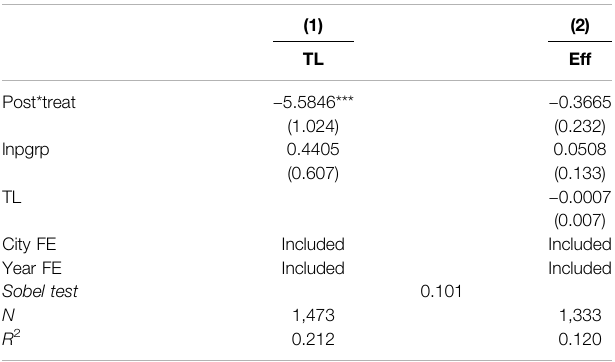
TABLE 10 | The industrial structure optimization mechanism of low-carbon city pilot